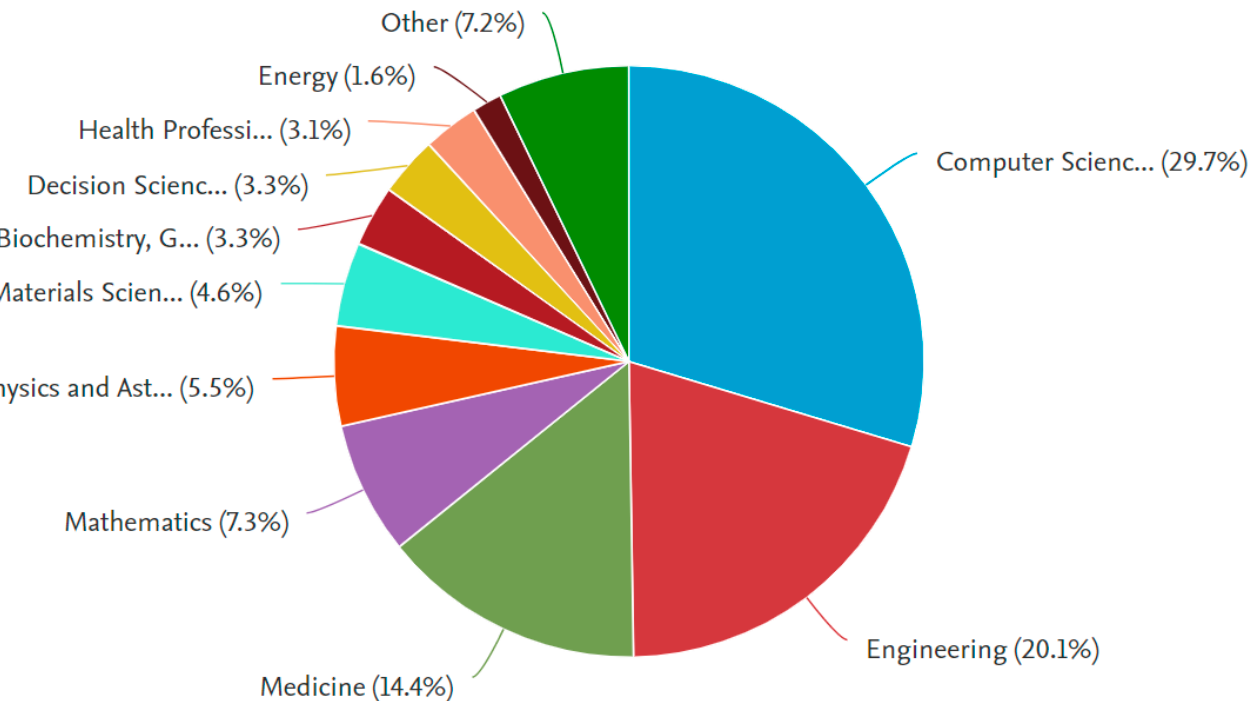
Figure 11. Analysis of documents by subject area.